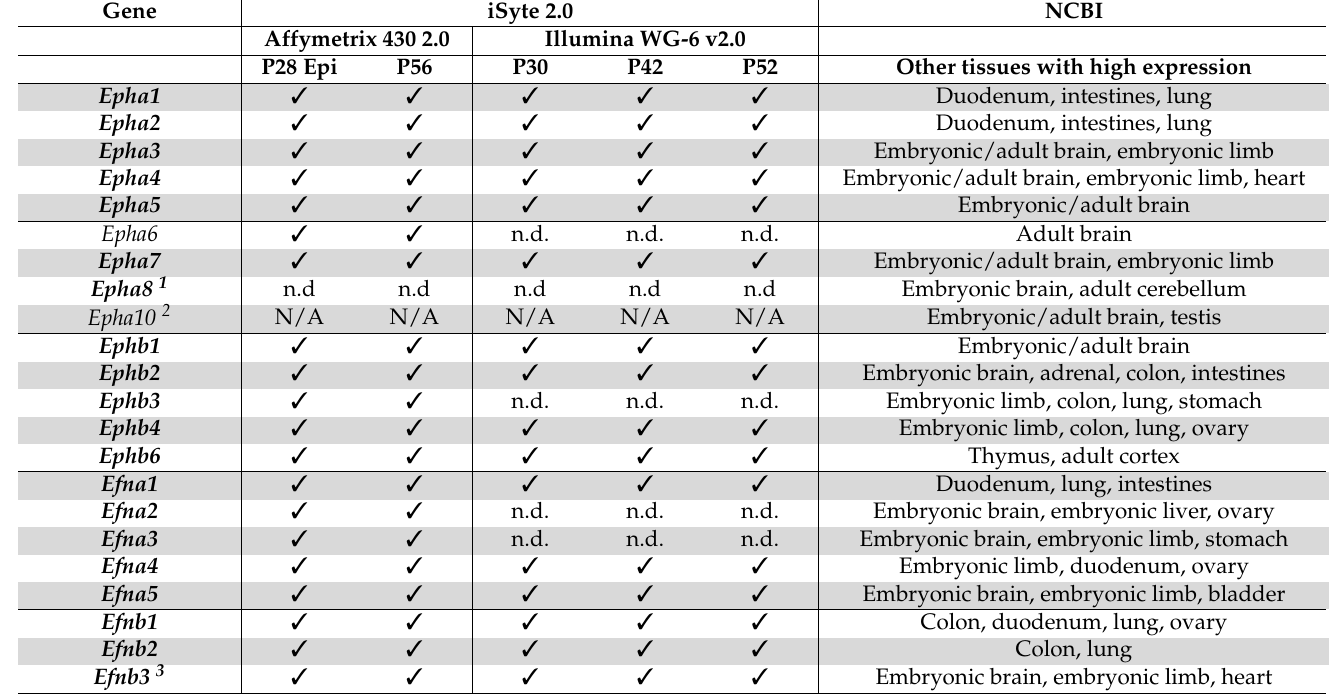
Table 2. Eph and Efn transcripts in lens microarray studies and other tissues. Gene iSyte 2.0 NCBI Affymetrix 430 2.0 Illumina WG-6